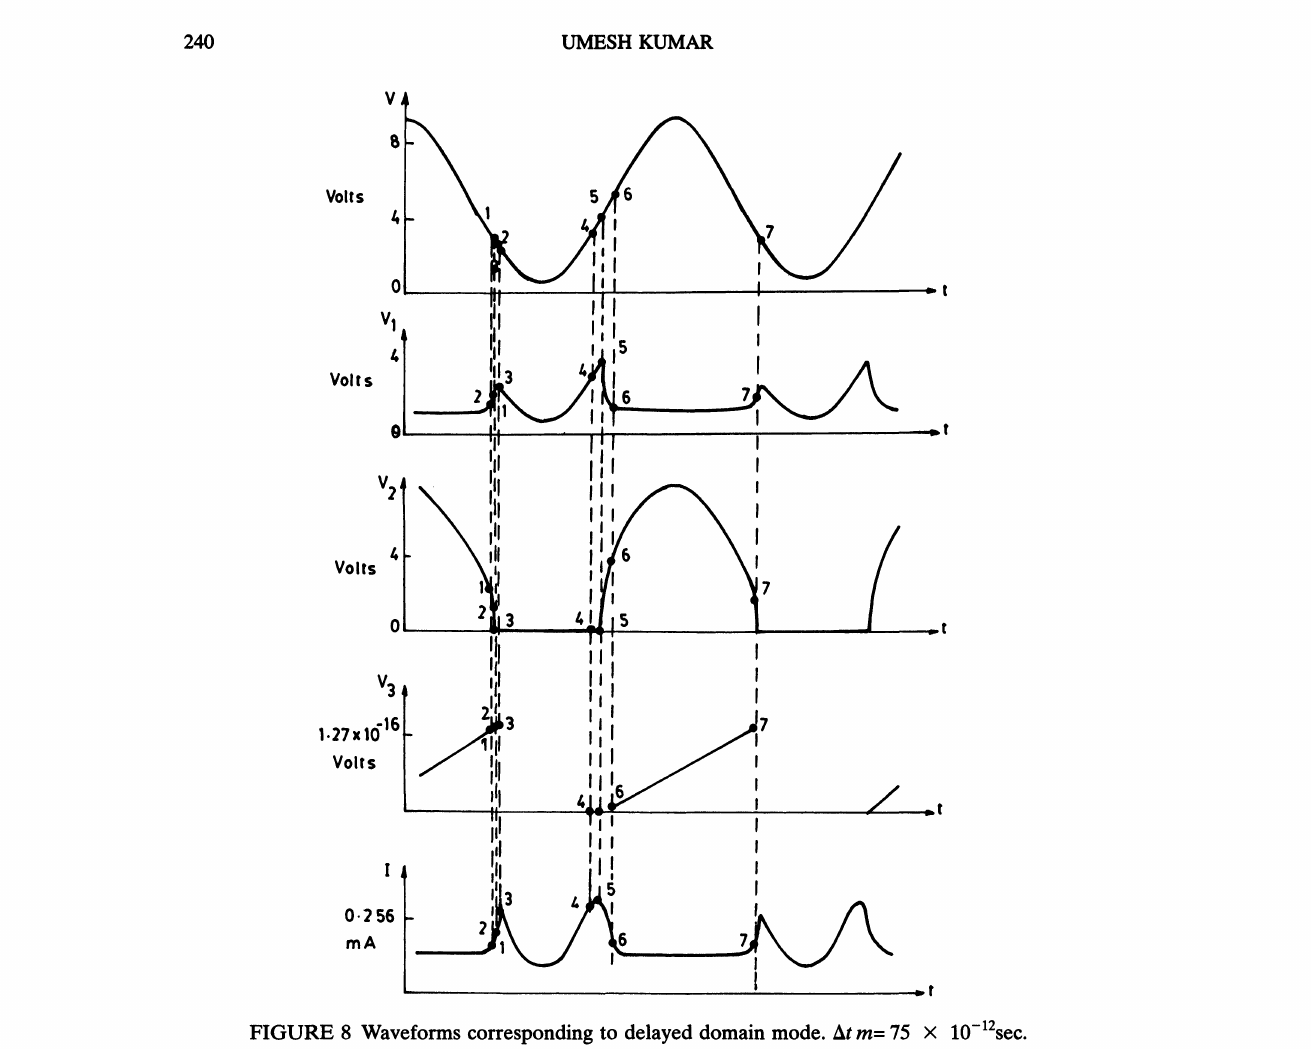
FIGURE 8 Waveforms corresponding to delayed domain mode. At m= 75 X